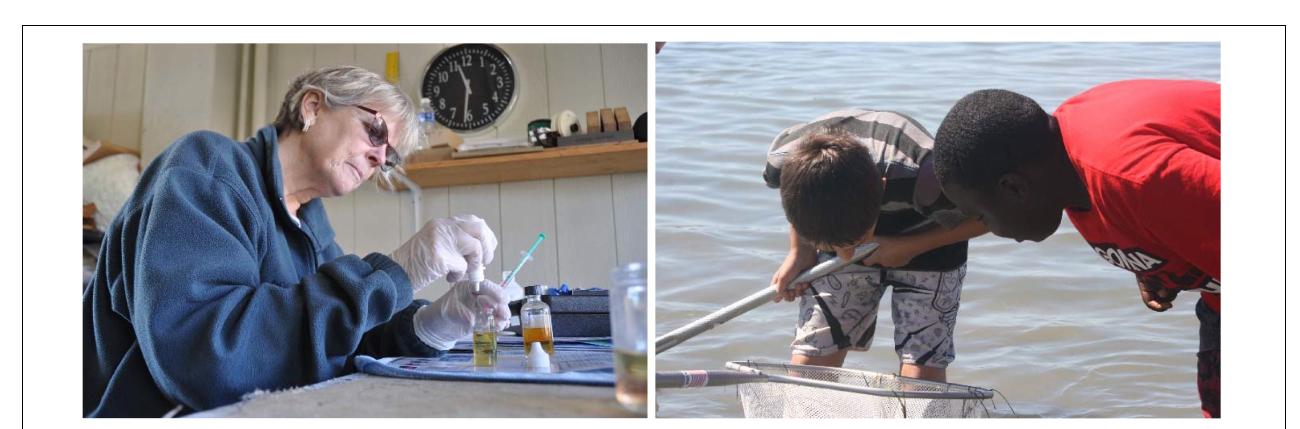
FIGURE 9 | Galveston Bay Foundation’s Water Monitoring Team volunteers collect monthly water quality data from sites around Galveston Bay (Left) . Nature’s Academy participants conduct biodiversity assessments as part of their outdoor education curriculum (Right) . Photo credits: GBFWMT (Left) and Chris Simoniello (Right)